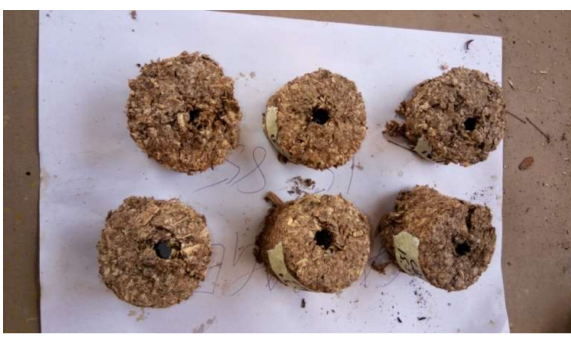
Figure 4. Samples of briquettes produced.